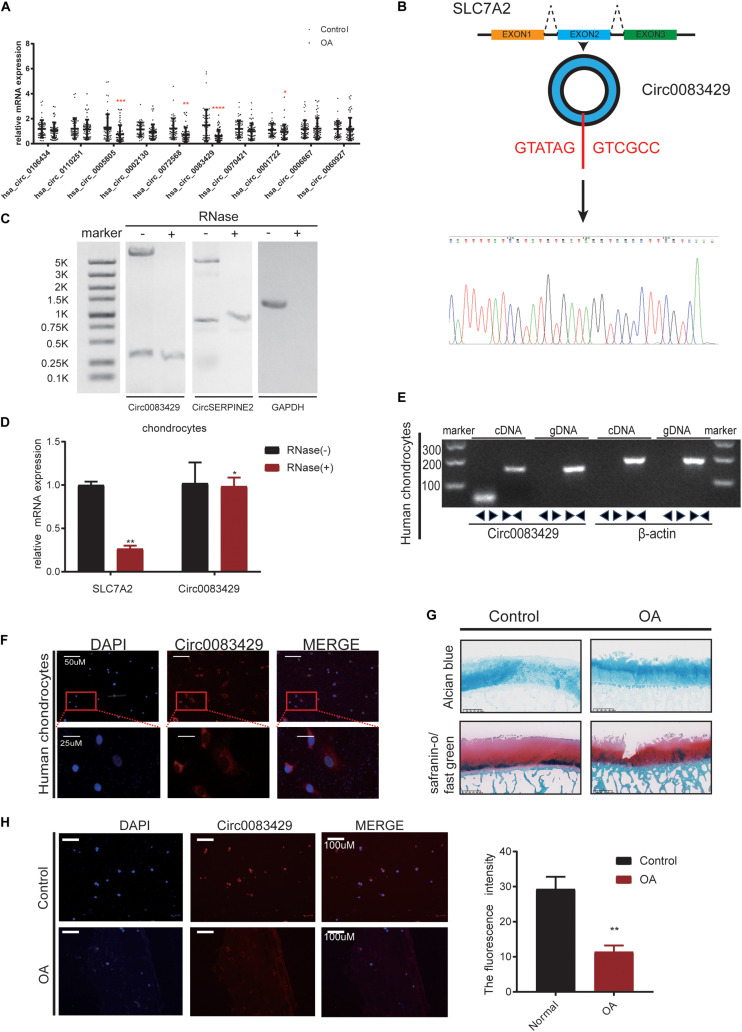
Osteoarthritis (OA) cartilage exhibits less Circ0083429 expression than that of non-OA cartilage. (A) Human OA (weight-bearing area) cartilage tissues exhibited less Circ0083429 expression than that of the human control (non-weight-bearing area) cartilage tissues. Data represent mean ± standard deviation (SD) (n = 20); *P < 0.05. (B) Schematic diagram showing that Circ0083429 (blue ring) is formed by the head-to-tail splicing of the second exon of the host SLC7A2 gene. The results of Sanger sequencing confirmed the existence of Circ0083429. The red letters indicate the binding sites from head to tail. (C) After RNase treatment of total RNA, northern blot was performed to test the exist of Circ0083429 in chondrocytes, CircSERPINE2 (Shen et al., 2019) was used as the positive control, and GAPDH was used as negative control. (D) The expression of Circ0083429 and mRNA SLC7A2 in chondrocytes was quantified by qRT-PCR after treatment with or without RNase R. Data represent the mean ± SD (n = 3); *P < 0.05. (E) DNA gel electrophoresis confirmed the existence of Circ0083429 by revealing that divergent primers can amplify Circ0083429 from cDNA, but not from genomic DNA in chondrocytes. Divergent primers cross through the splicing site of Circ0083429. Actin served as a positive control. (F) Fluorescence in situ hybridization (FISH) analysis revealed that Circ0083429 localized in the chondrocyte cytoplasm. Circ0083429 probes were labeled with Alexa Fluor 488, and nuclei were stained with 4,6-diamidino-2-phenylindole. (G) Alcian blue staining and safranin O/fast green staining of the cartilage from patients with weight-bearing and non-weight-bearing areas. Scale bar = 625 μm. (H) FISH analysis revealed that OA cartilage (weight-bearing area) tissues exhibited less Circ0083429 expression than the control cartilage (non-weight-bearing area) tissues. **p < 0.005.